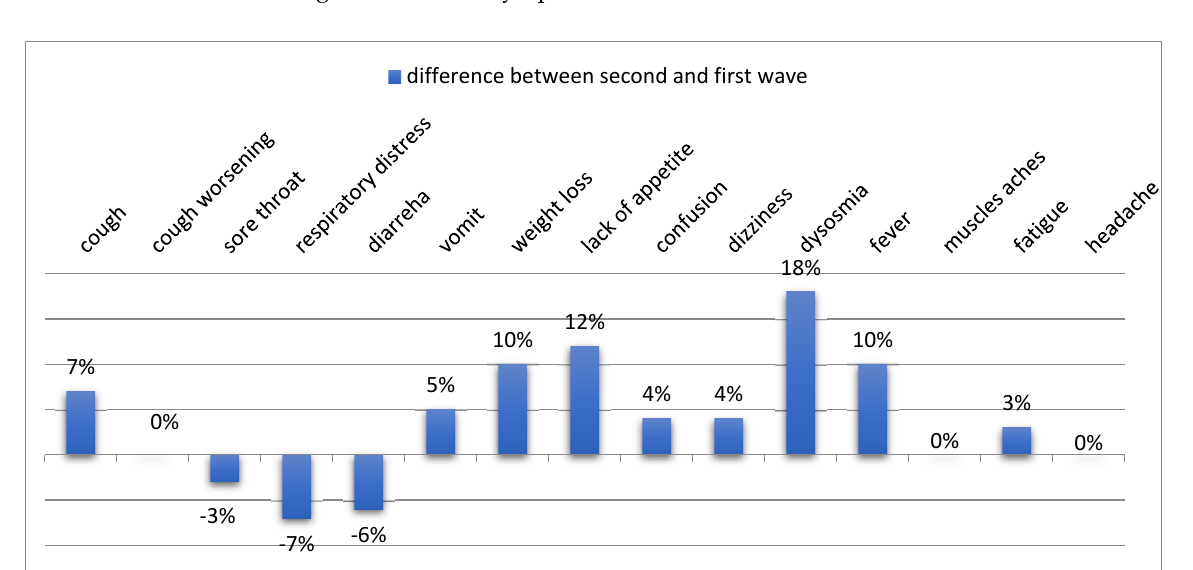
Figure 5. Percentage of patients reporting each symptom: differences between the two waves.